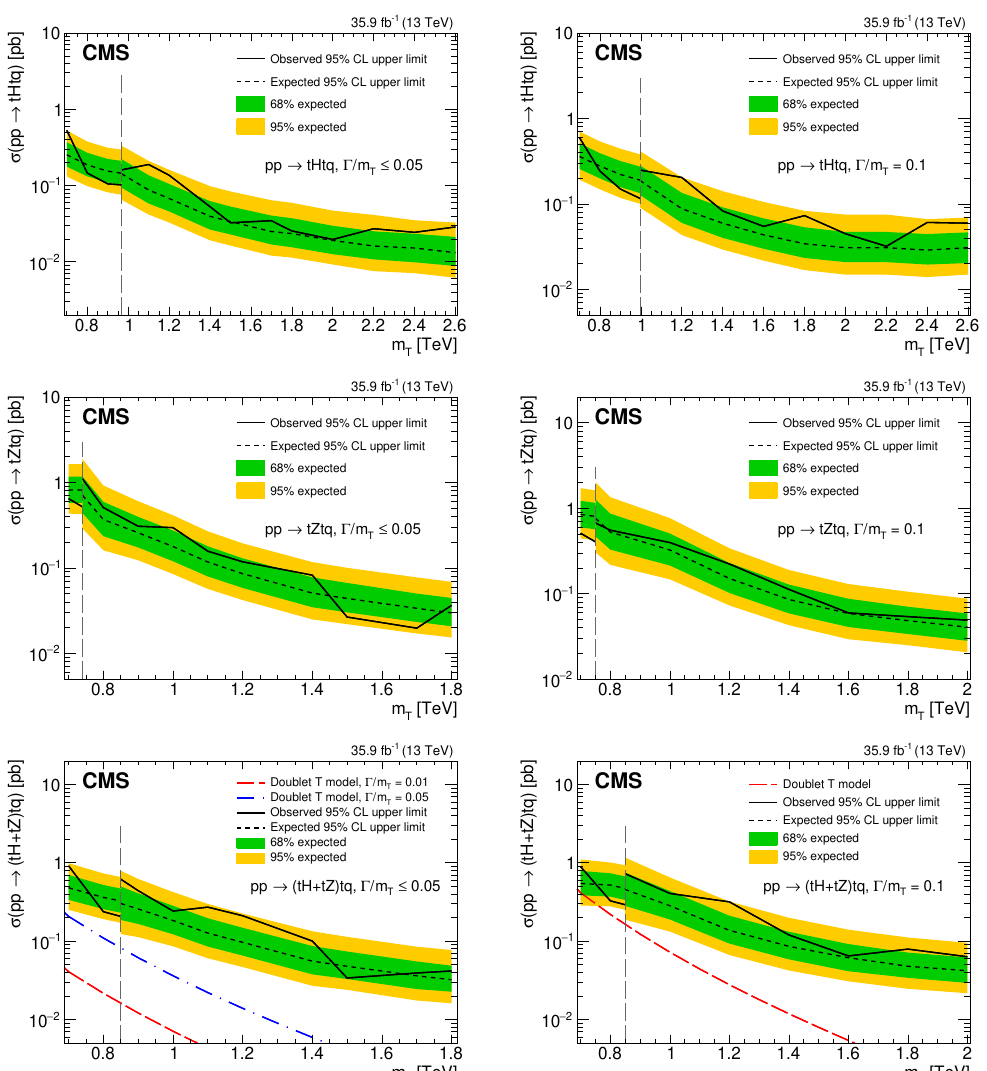
Figure 10 . The observed and median expected upper limits at 95% CL on the cross sections for production associated with a top quark for the tHtq (upper row) and tZtq (middle row) channels, and their sum, tHtq+tZtq (lower row), for di(cid:11)erent assumed values of the T quark mass. The inner (green) band and the outer (yellow) band indicate the regions containing 68 and 95%, respectively, of the distribution of limits expected under the background-only hypothesis. The left column is (cid:20) 0 : 05) and the right column is for a fractional width of for a narrow fractional width ((cid:0) =m T (cid:0) =m = 0 : 1. The vertical dashed lines are the crossover points in sensitivity that indicate the T mass intervals used for presenting the low-mass and high-mass search results. The dashed red and dot-dashed blue curves are for the (TB) doublet model. Given the speci(cid:12)ed width, the couplings are implicit in the model. Two curves corresponding to (cid:0) =m = 0 : 05 (dot-dashed blue) and T (cid:0) =m = 0 : 01 (dashed red) are shown for the narrow fractional width. T